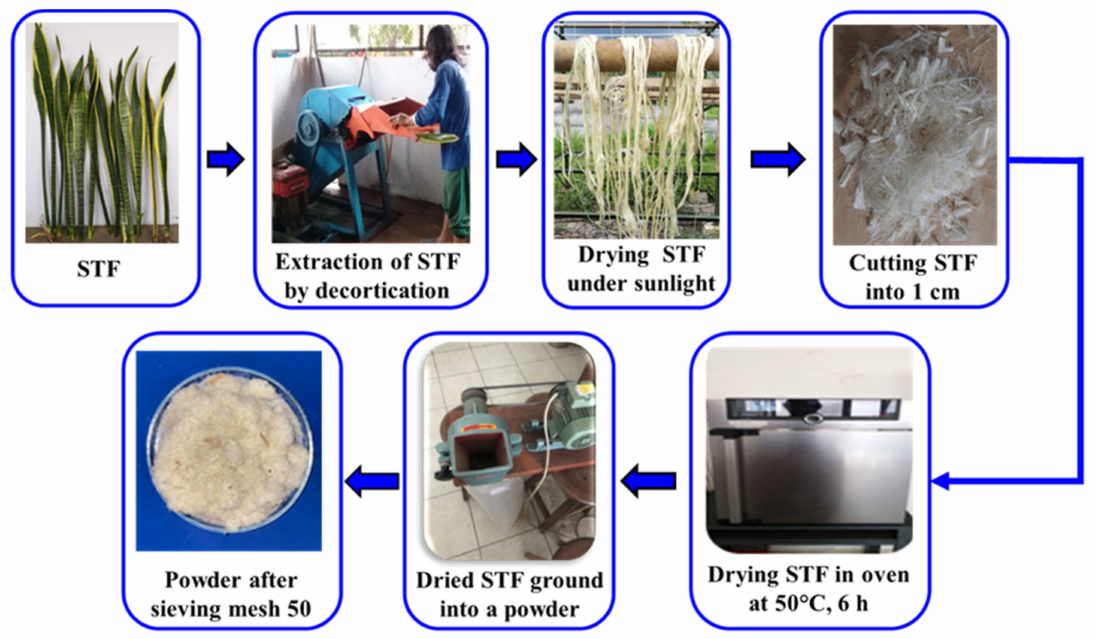
Figure 1. Extraction process of